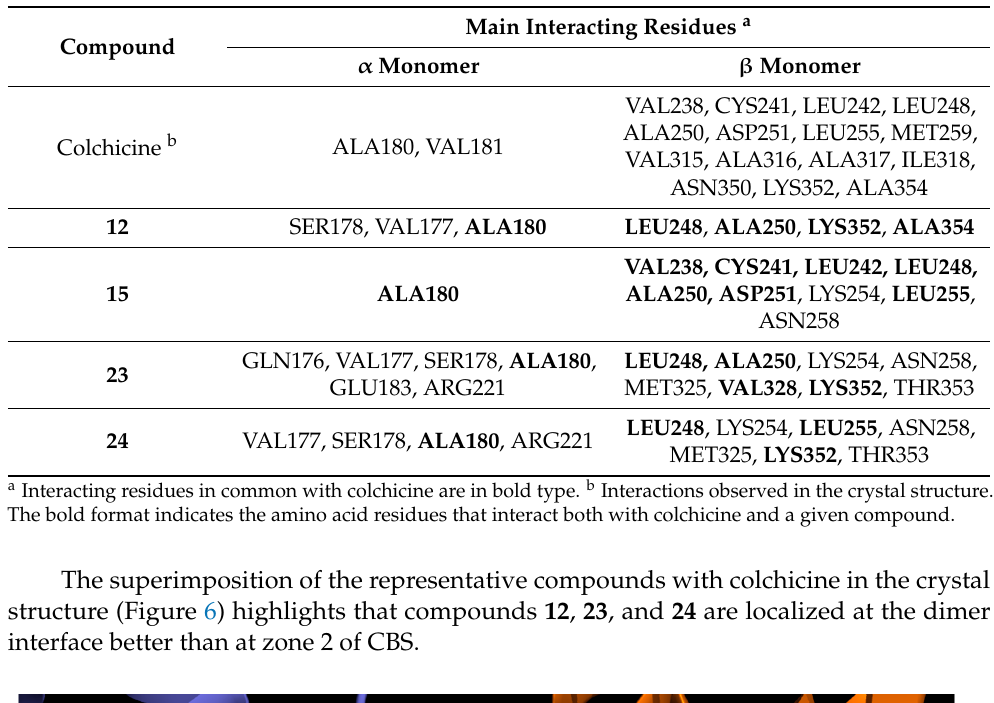
Table 5. Comparison of the main interacting residues of representative compounds observed by molecular docking and the binding mode of colchicine in the crystal structure of tubulin dimer.